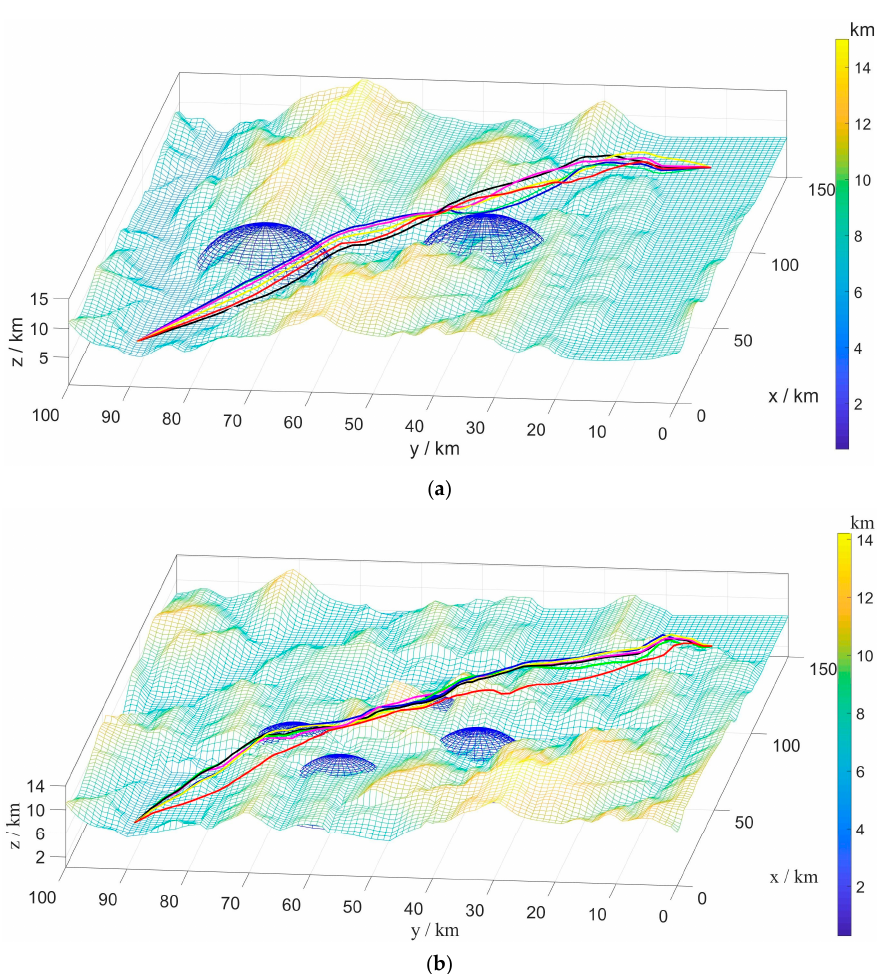
Figure 9. Path planning results of BINN-HHO on a 3D simulation map. ( a ) Static case I. ( b ) Static case II.